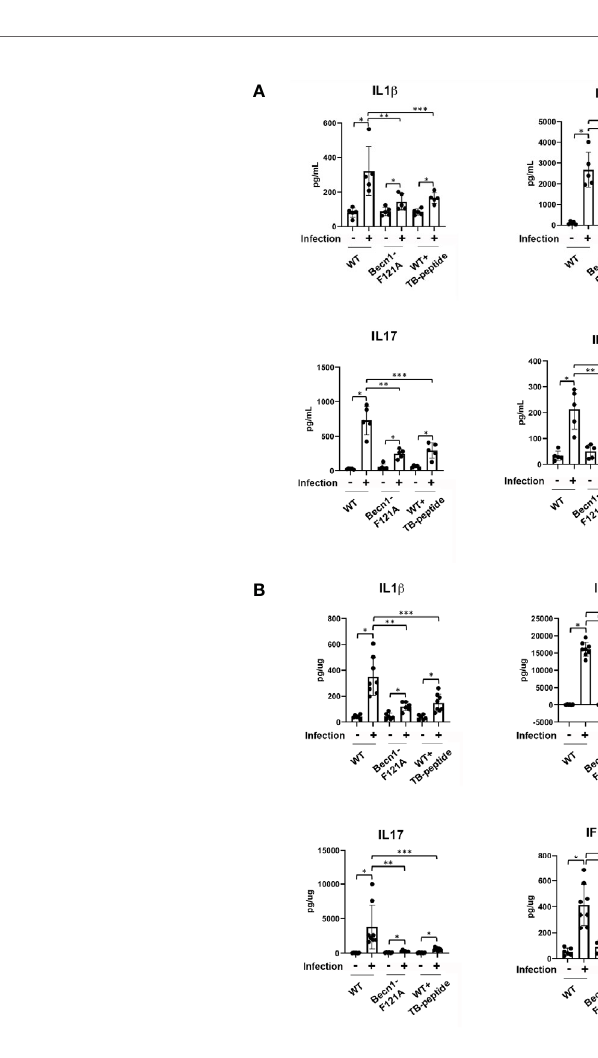
FIGURE 3 | Beclin-1 – dependent autophagy attenuates systemic cytokines and pulmonary cytokines in pneumonia-induced sepsis. Mice of WT and Becn1 F121A/ F121A were given septic infection by K. pneumoniae (3X10 7 CFU/mouse, intubation) or PBS (uninfected). In parallel groups, infected and uninfected mice were treated with TB-peptide (16.5 mg/kg) or PBS vehicle 1 h post-infection. Serum was collected and lung tissue harvested 48 h post-infection. Cytokines in serum (A) and in lung tissue lysates (B) were measured by ELISA assays. All values are means ± SEM. Signi fi cant differences are shown as * for uninfected vs . infected, ** for WT vs . Becn1 F121A/F121A , and *** for TB-peptide treated vs. untreated ( p < 0.05, n ≥ 5, student